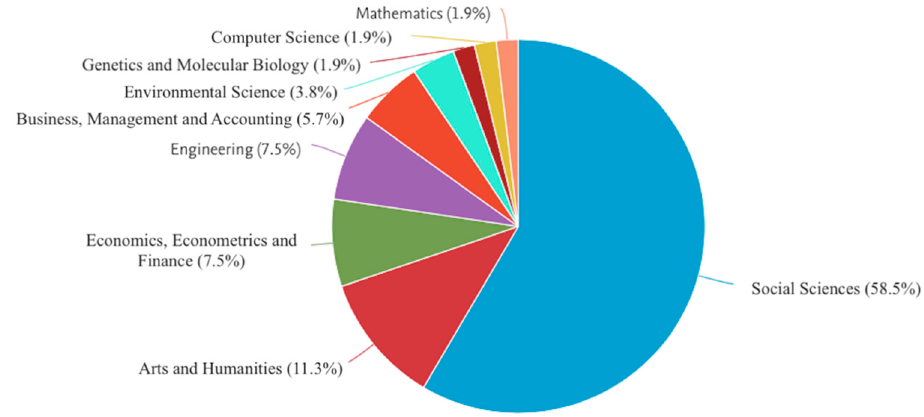
Figure 4. Documents by type (source: own authorship).